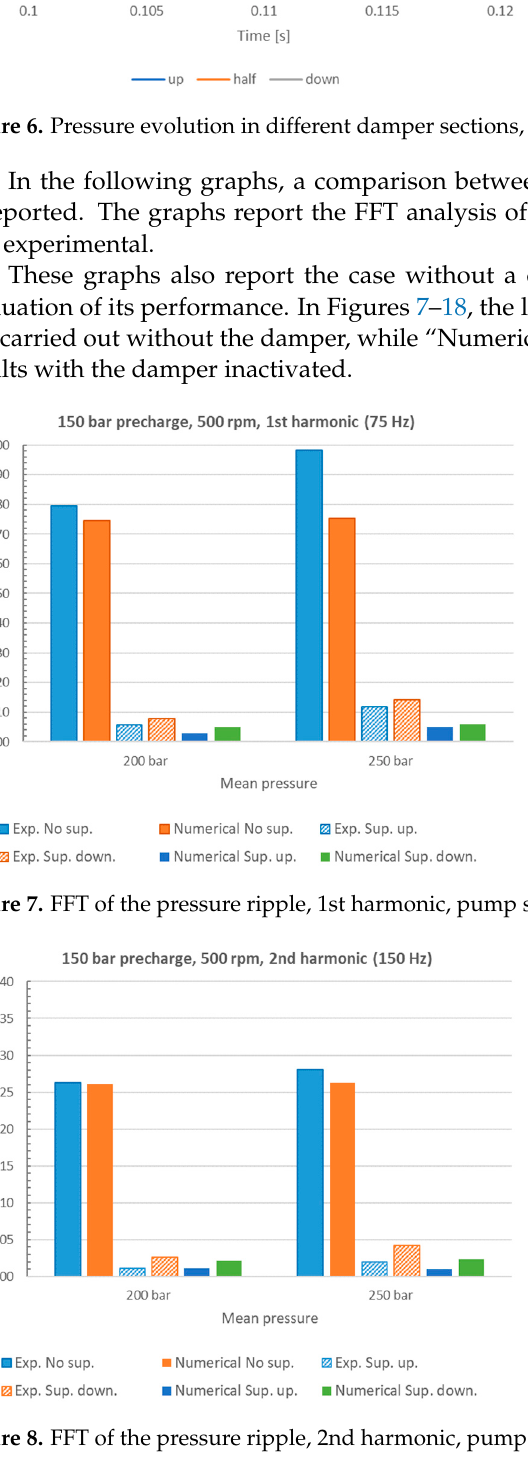
Figure 6. Pressure evolution in different damper sections, pump speed = 1500 rpm.